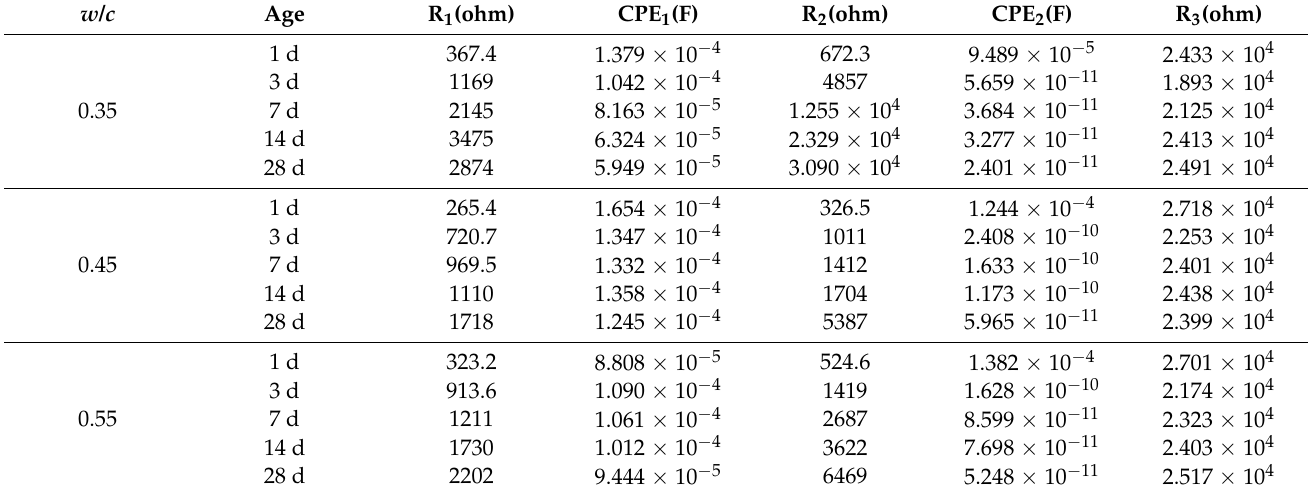
Table A1. Electrochemical parameters of an equivalent circuit R{CR}{CR} in Nyquist curves Figure 6. w /